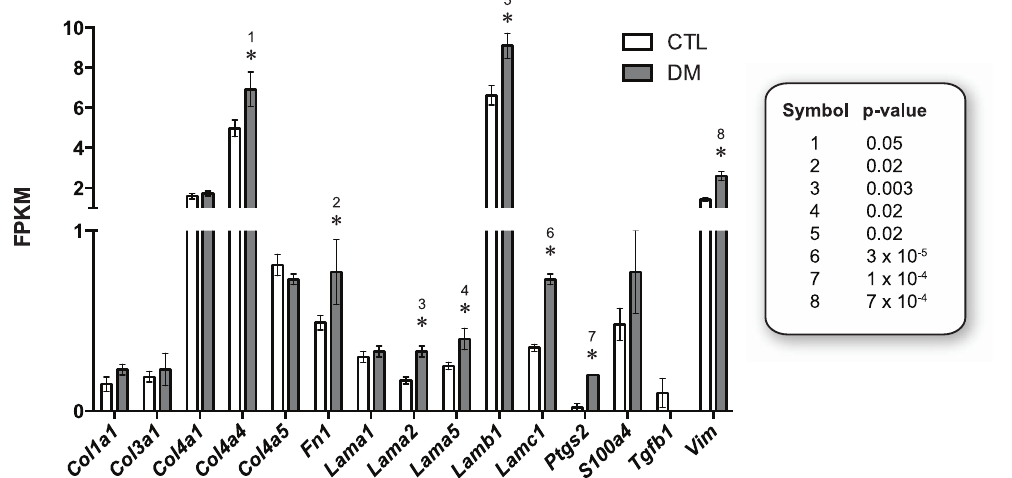
Figure 8. Candidate diabetes-associated gene products in the OVE26 model. Owing to the high significance threshold arising from the multiple comparisons-informed transcriptome-wide statistical approach, a number of expected diabetes candidate genes did not achieve significance at the transcriptome level in the present model, and were not represented in the functional annotation-based analysis. Raw expression data were queried for fifteen candidate genes and tested for nominal significance (P , 0.05) via t -test (see text). Eight of the 15 gene products – particularly members of the laminin gene family – were upregulated in the OVE26 kidneys (relative to control kidneys). P -values for the depicted differences (relative to CTL or to DM) are shown in the right panel and are keyed to numbers over the significance symbols. S100a4 is also known as Fsp1 , and Ptgs2 (prostaglandin-endoperoxide synthase 2, or prostaglandin G/H synthase and cyclooxygenase) is also known as cyclooxygenase-2 (COX-2).